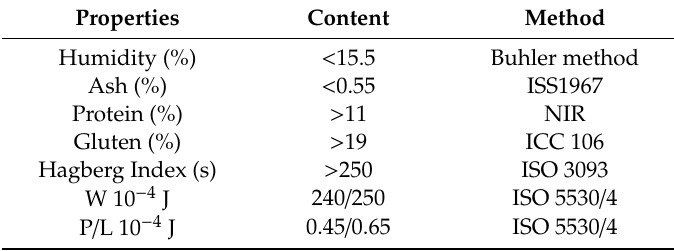
Table A1. Chimico-physical and reological properties reported in technical data sheet of the “00 Rapid” wheat